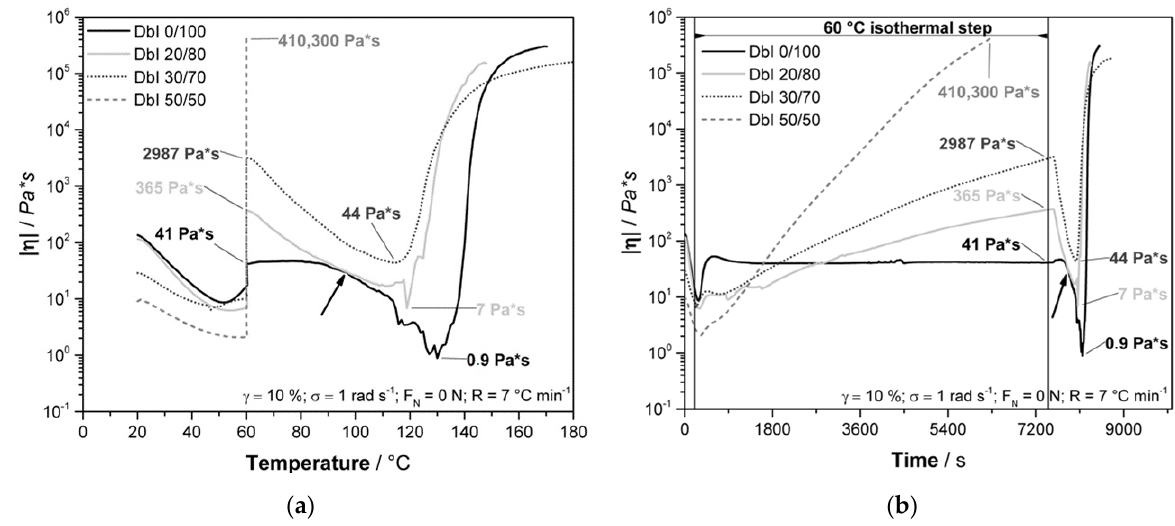
Figure 4. Results from the process-related rheological analysis of DbI systems with an IPDA/B-IPDA blend ratio of 0/100 w , 20/80 w , 30/70 w and 50/50 w . ( a ) Rheological results dependent on the temperature, ( b ) rheological results dependent on the time with indicated 60 °C isothermal step, with both indicated viscosities after pre-curing and minimum viscosity during the foaming.